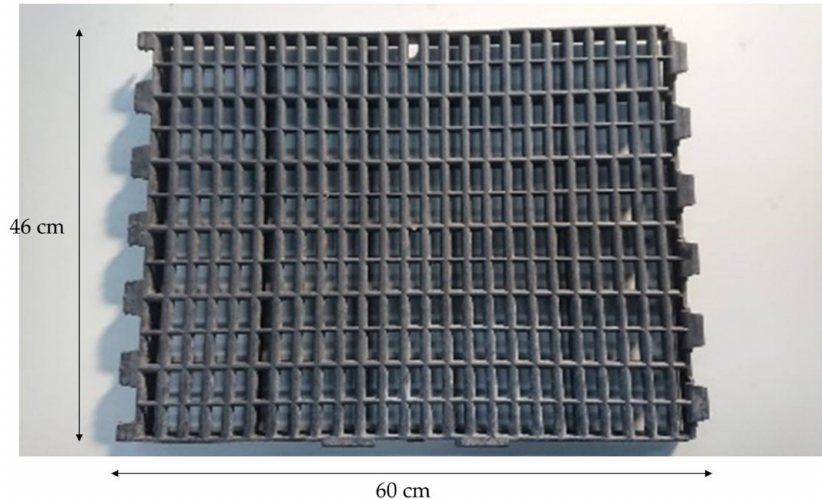
Figure 2. Perforated plastic floor used in the experiment. The size of each perforated plastic floor